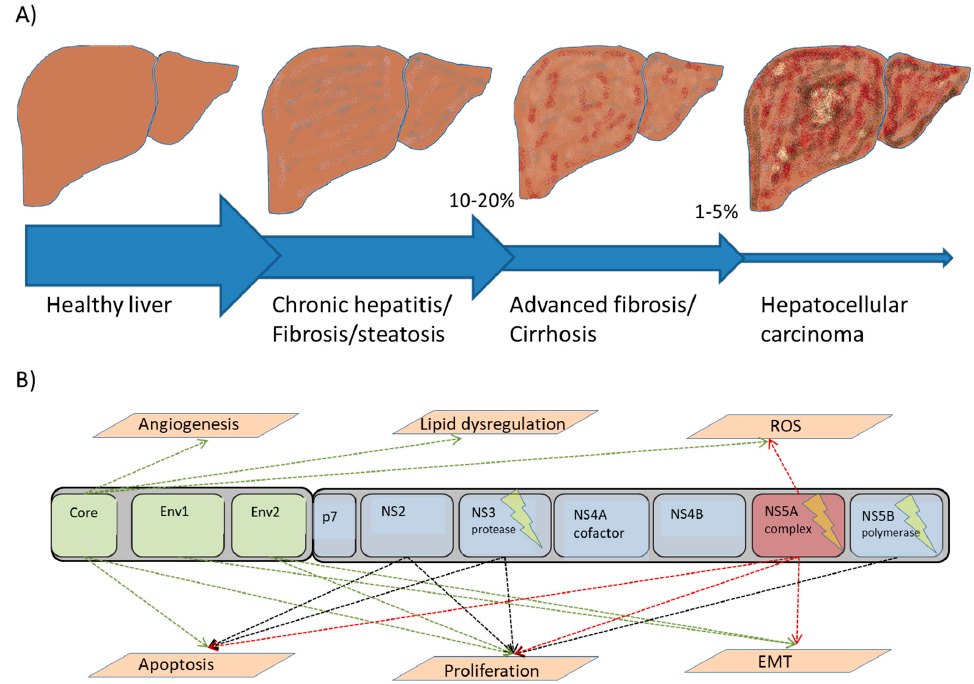
Figure 2. Hepatitis C virus-induced hepatocarcinogenesis. ( A ) HCV-induced hepatocarcinogenesis proceeds slowly over a span of 20–40 years accompanied by progressive fibrogenesis and eventually cirrhosis. ( B ) Both structural (Core, E1, E2) and non-structural proteins (NS2, NS3, NS5A, NS5B) play direct or indirect roles in hepatocarcinogenesis through oxidative stress, proliferation, apoptosis, chronic inflammation, dysregulated lipid metabolism, and angiogenesis. DAA targets are indicated using lightning symbols. ROS: reactive oxygen species; EMT: epithelial/mesenchymal transition.